Question: Briefly state, in one sentence, what is plotted here.
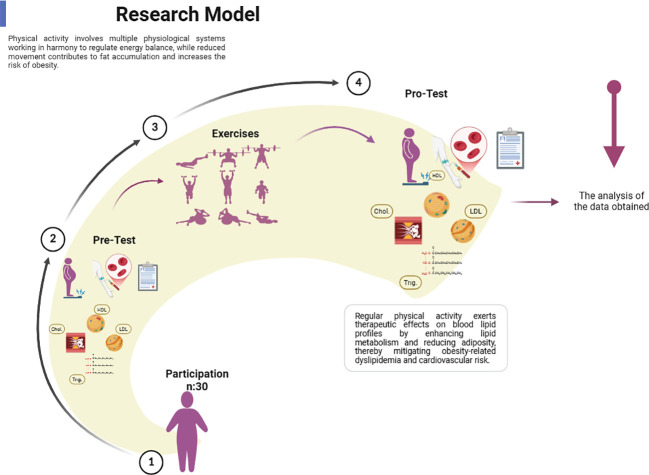
Answer: The study flow and assessment procedures.